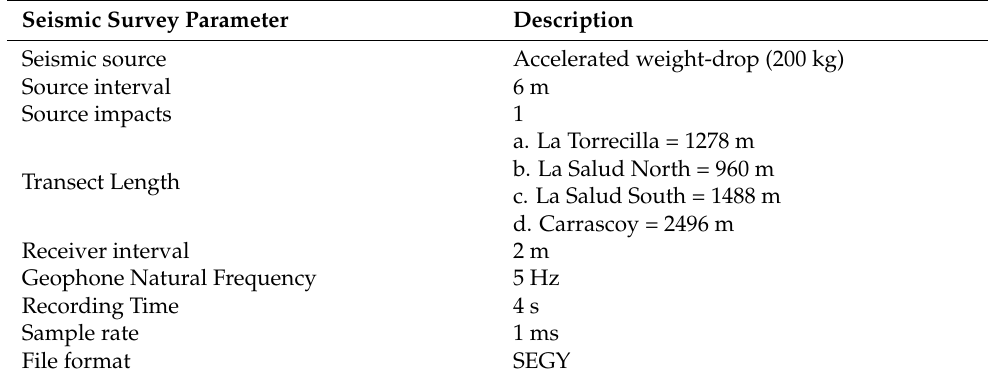
Table 2. Description of the seismic parameters in the study area.